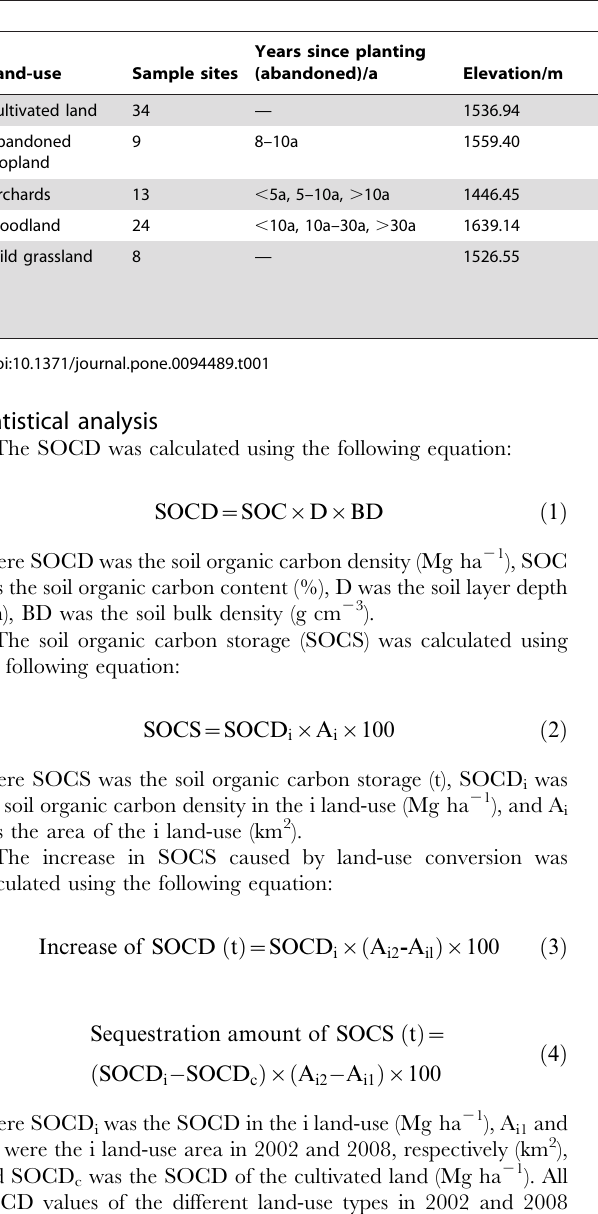
Table 1. Attributes of the studied